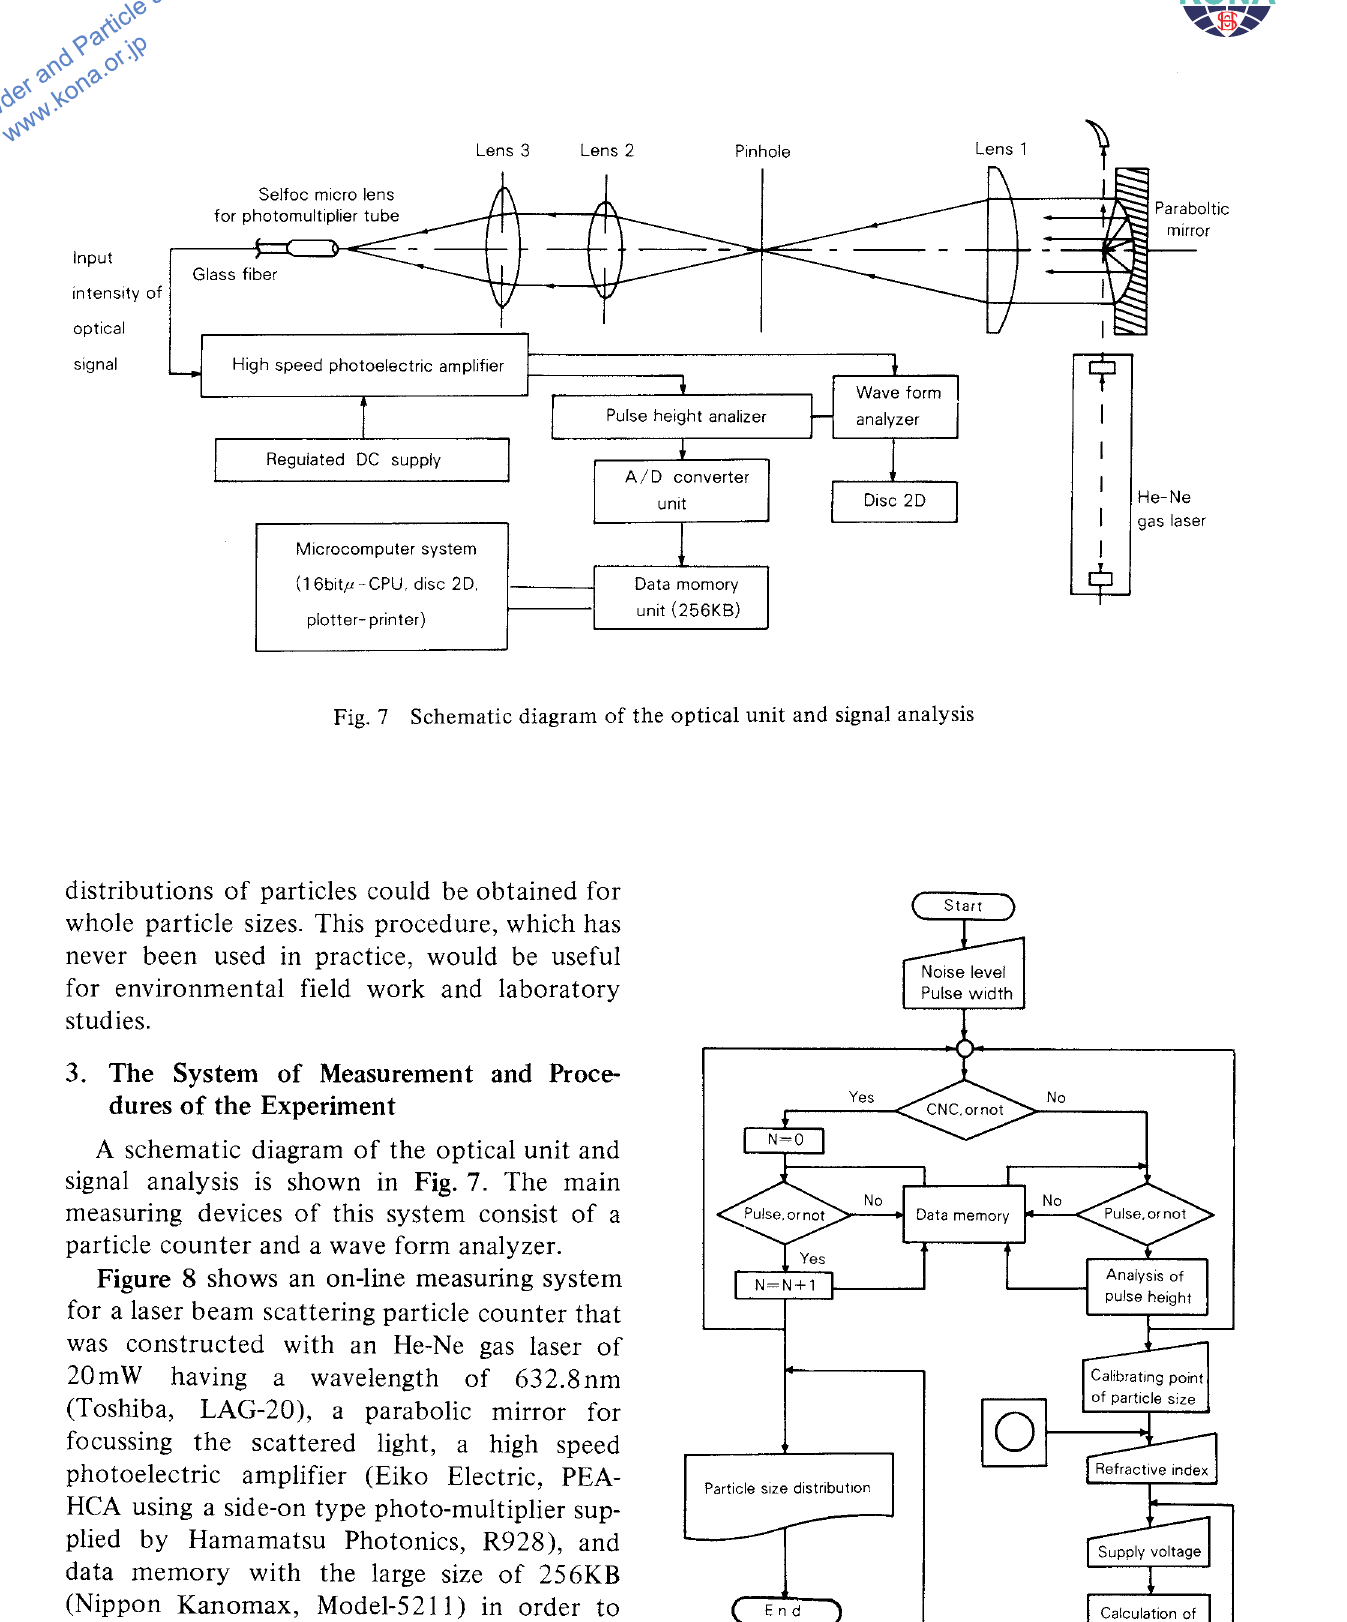
Fig. 8 Flow chart of software for data reduction